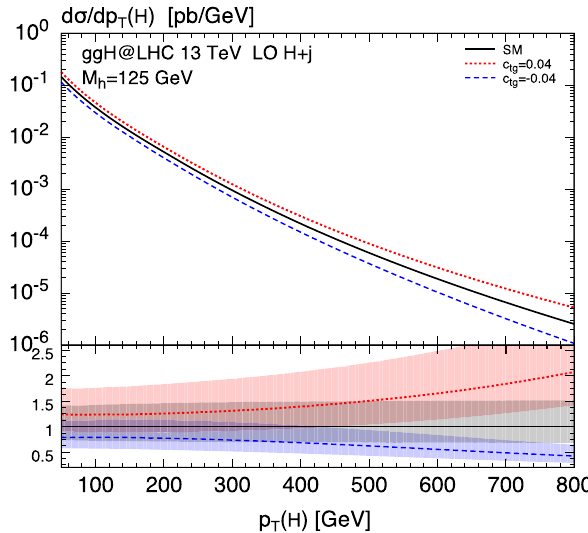
Fig. 5 Impact of the chromomagnetic operator on the p T spectrum of the Higgs boson in the region allowed by the current experimental